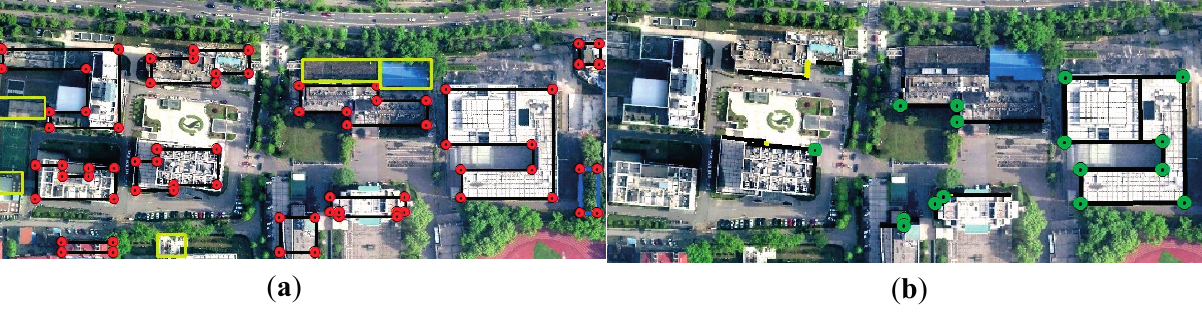
Figure 1. Building corner extraction from airborne and terrestrial LiDAR data. ( a ) Extracted building corners (red points) and contours (black lines) from airborne LiDAR data; ( b ) extracted building corners (green points) and contours (black lines) from terrestrial LiDAR